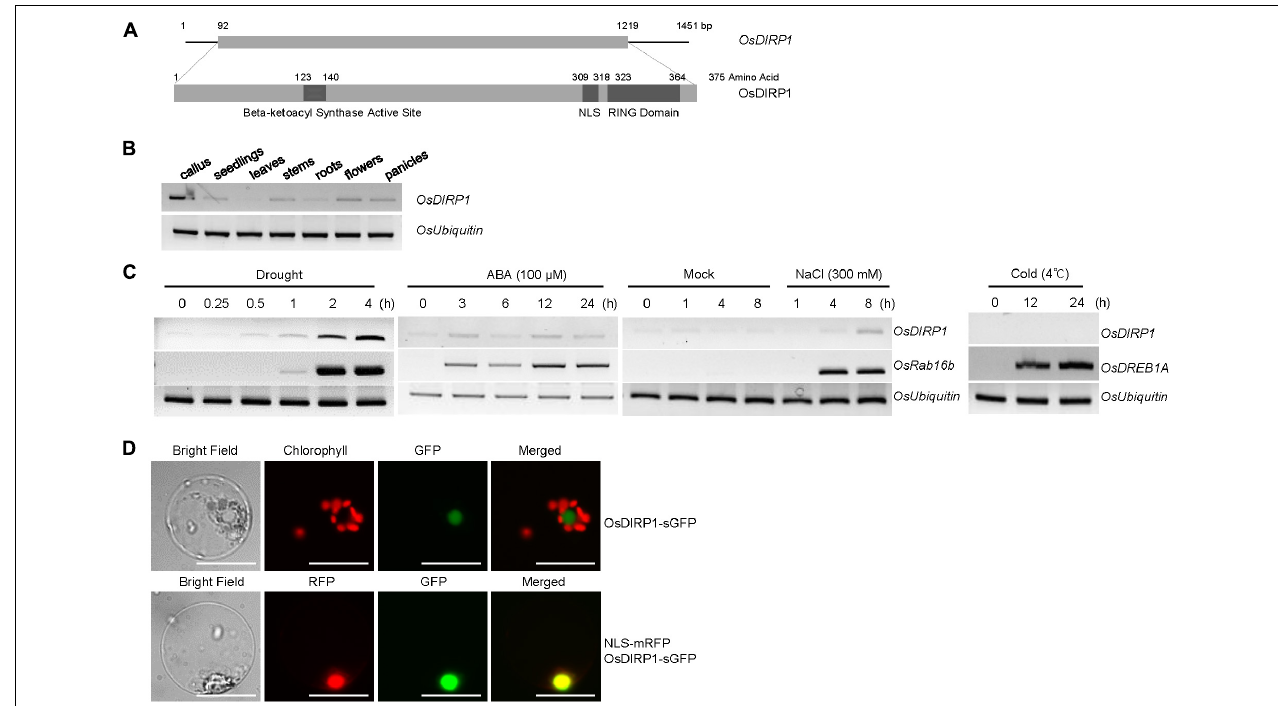
FIGURE 1 | Identification and characterization of OsDIRP1 in rice. (A) (Upper) Schematic diagram of full-length OsDIRP1 cDNA. The solid bar depicts the coding region. The solid lines represent the 5’- and 3’-untranslated regions. (Lower) Schematic structure of OsDIRP1. The putative beta-ketoacyl synthase active site, nuclear localization sequence (NLS), and RING motif are shown as dark gray bars. (B) RT-PCR analysis of OsDIRP1 in different tissues of rice plants. Total RNA was isolated from various rice tissues as indicated and analyzed by RT-PCR. OsUbiquitin was used as an equal loading control. (C) Expression patterns of OsDIRP1 in response to various abiotic stresses in rice plants. Light-grown, 10-day-old wild-type seedlings were subjected to drought, salt, cold, and ABA treatments at different time points as indicated. OsUbiquitin was used as an internal control for all the RT-PCR analyses. OsRab16b was used as a positive control for drought, salt, and ABA treatments, whereas OsDREB1A was used as a positive control for cold stress. (D) Subcellular localization of OsDIRP1. A 35S:OsDIRP1-sGFP fusion construct was transfected into wild-type rice protoplasts, and the fluorescent signals of the expressed proteins were visualized by fluorescence microscopy under dark-field conditions. sGFP and NLS-mRFP were used as cytosol- and nucleus-localized marker proteins, respectively. Bars = 5 µ